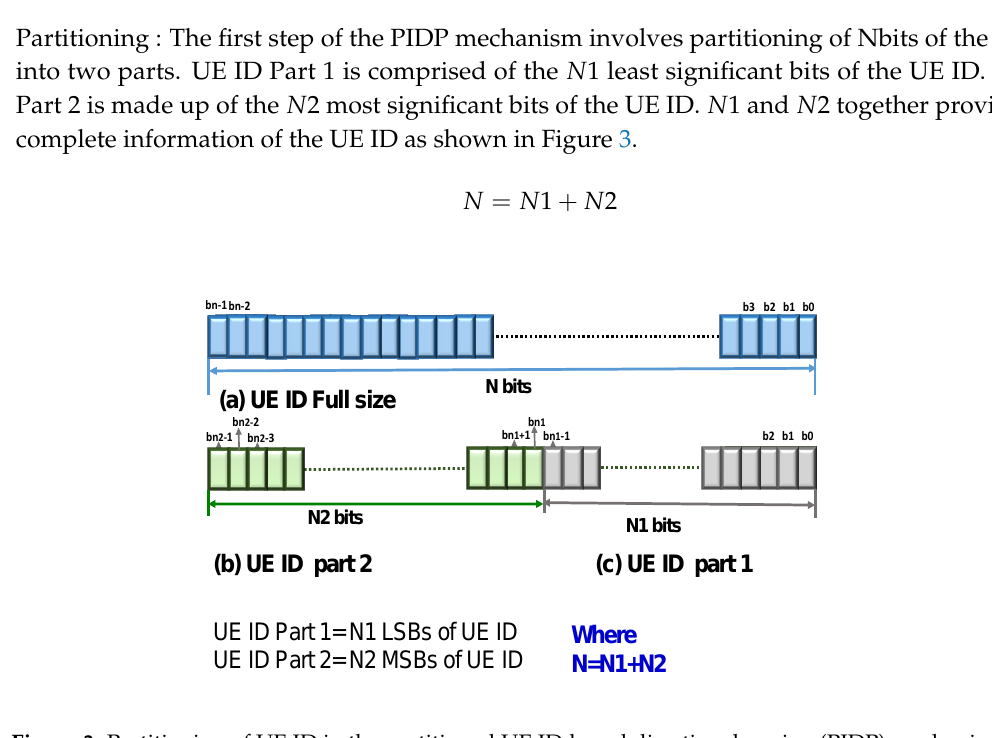
Figure 3. Partitioning of UE ID in the partitioned UE ID-based directional paging (PIDP)